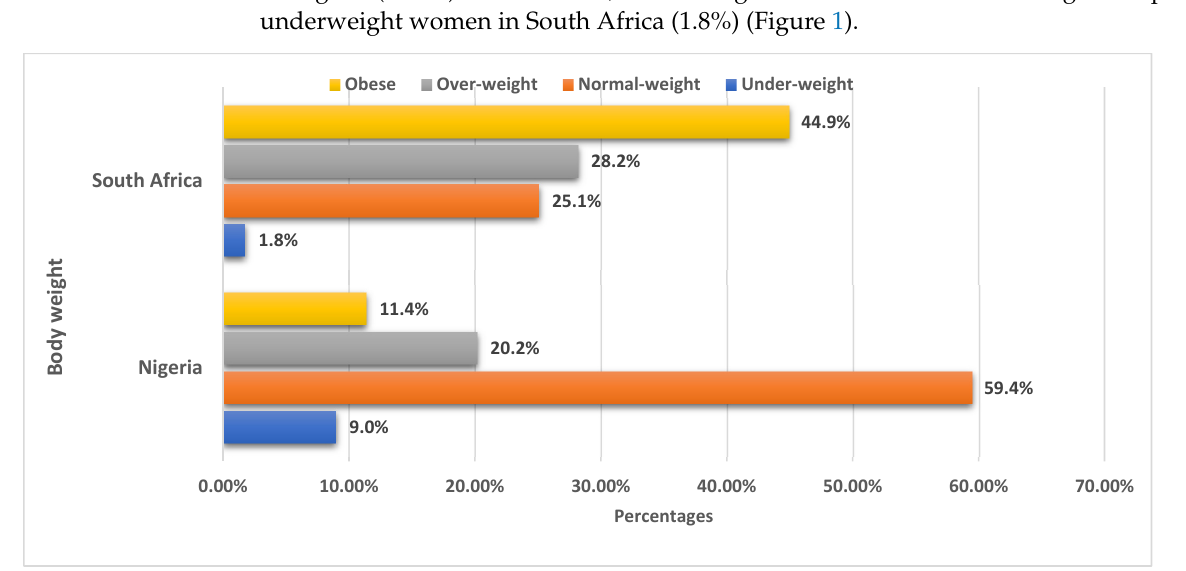
Figure 1. Overall prevalence of body weight among women of childbearing age (15–49 years) by country. Source: NDHS, 2018 and SADHS, 2016.